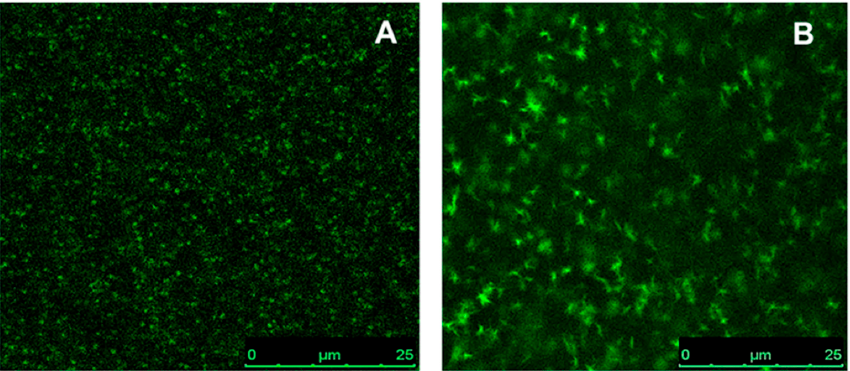
Figure 8. Typical images of ( A ) PFO and ( B ) F8T2 in neat ethyl cellulose film, observed by confocal microscopy. Excitation wavelength was 458 nm and emission wavelength in the range of 510–700 nm. These pictures have 512 × 512 pixels, using a pinhole of 1 AU, zoom 4 × , and 400 Hz. The scale bars are 25 µ m.